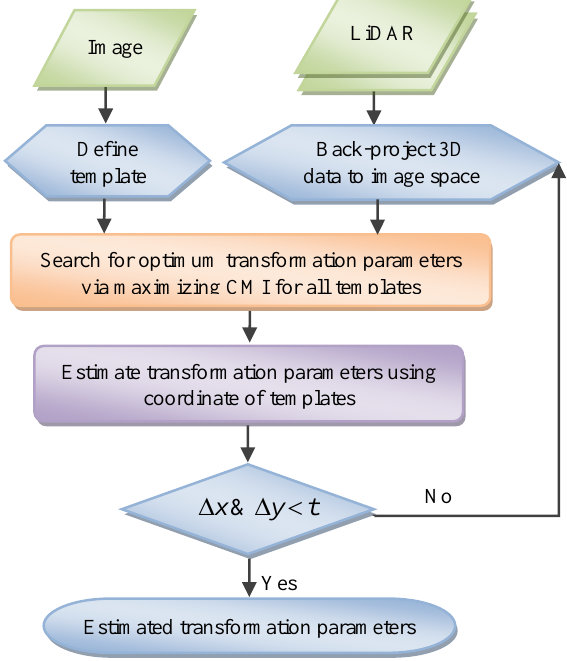
Figure 2. Flowchart of registration